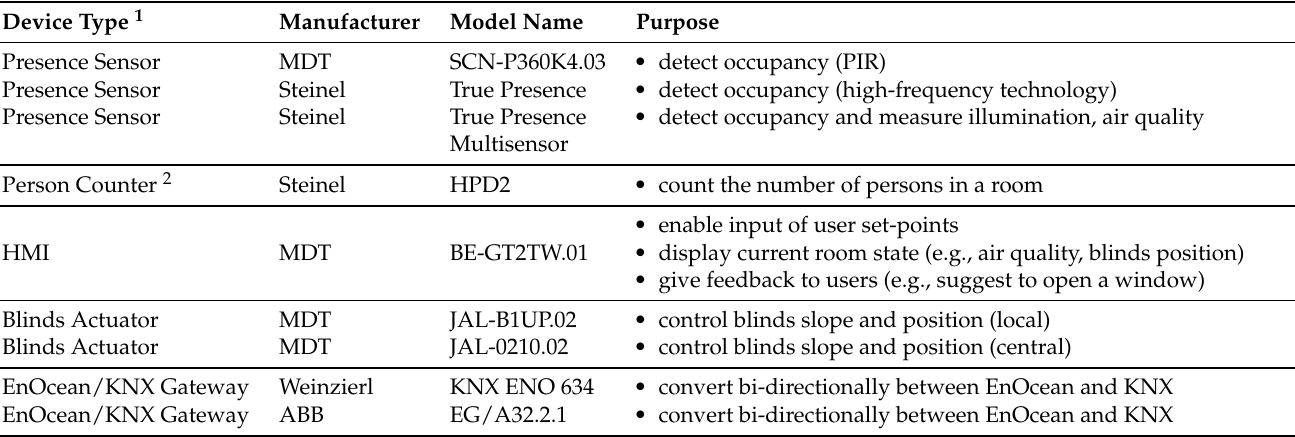
Figure 4. Equipment concept for one floor and wing of an examplary building layout using EnO- cean and KNX. The cables for backbones are orange for EnOcean and green for KNX. The KNX back- bones are only indicated for the room in the upper left side, to keep the figure readable. Table 5. Overview of KNX devices installed in addition to the EnOcean